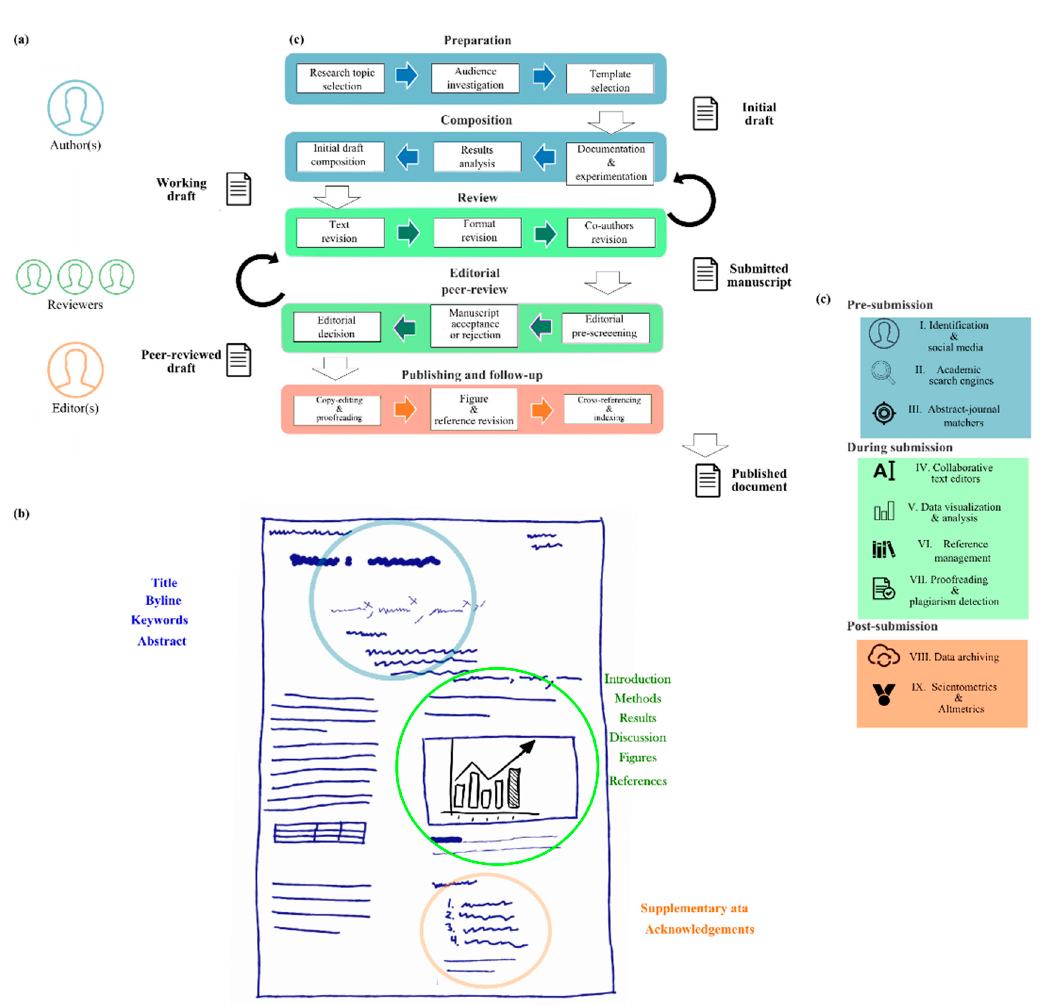
Figure 1. Peer-review process. ( a ) Stakeholders; ( b ) editorial process; ( c ) Information Technology and Communication (ITC) assisting tools software taxonomy.